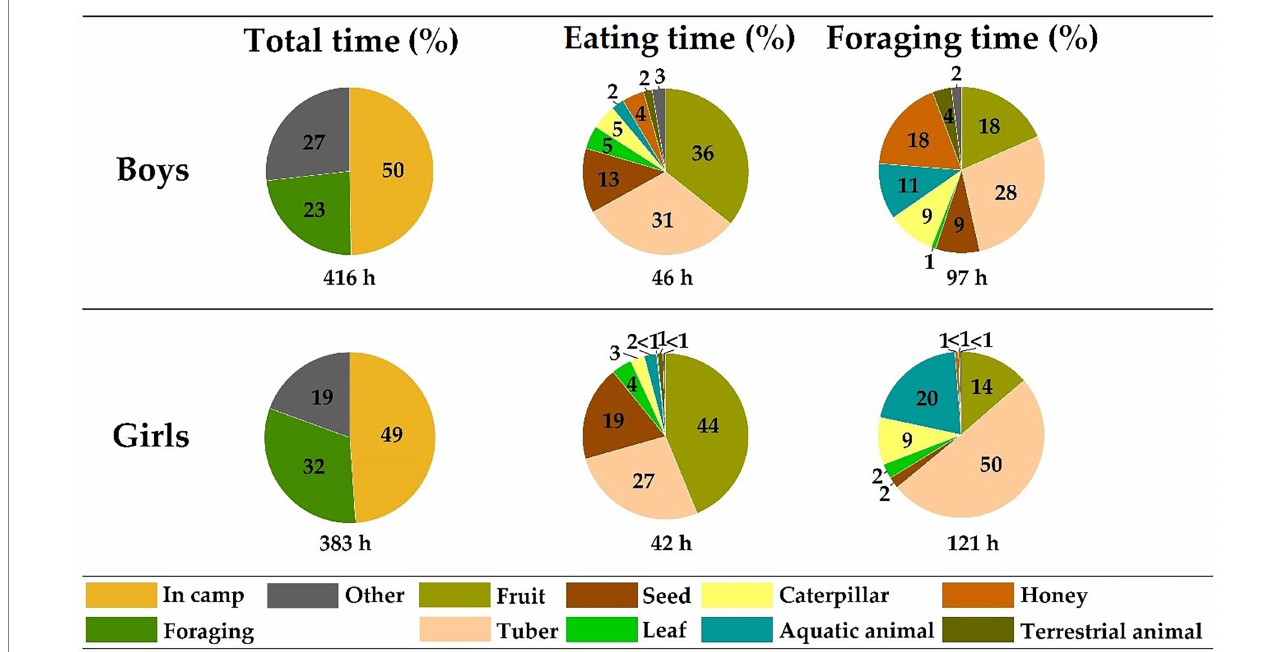
FIGURE 2 Differences in diet composition and foraging activities between boys and girls. Indicated is the difference in eating and foraging time on the food types between boys ( N = 13, median age = 10.2, range: 4.5–16.5; observation time: 416 h, eating time: 46 h, foraging time: 97 h) and girls ( N = 14, median age = 9.1, range: 5.5–17.1, observation time: 383 h, eating time: 42 h, foraging time: 121 h). The pie charts on the left indicate the percentage of time spent in camp, on foraging trips, and on trips unrelated to foraging. The middle and right pie charts indicate the percentage of time spent eating and foraging, respectively, on the different food types. For the definition and calculation of eating and foraging time, see